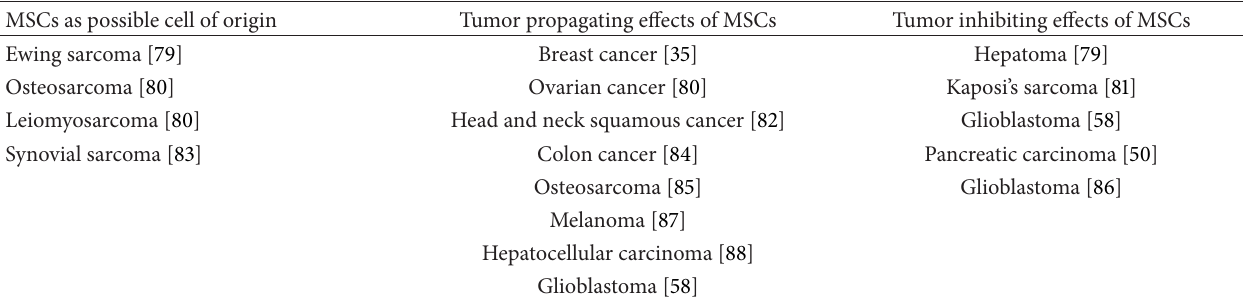
Table 5: Studies in which MSCs have been implicated as cell of origin for specific tumors or have been shown to display protumorigenic or antitumorigenic